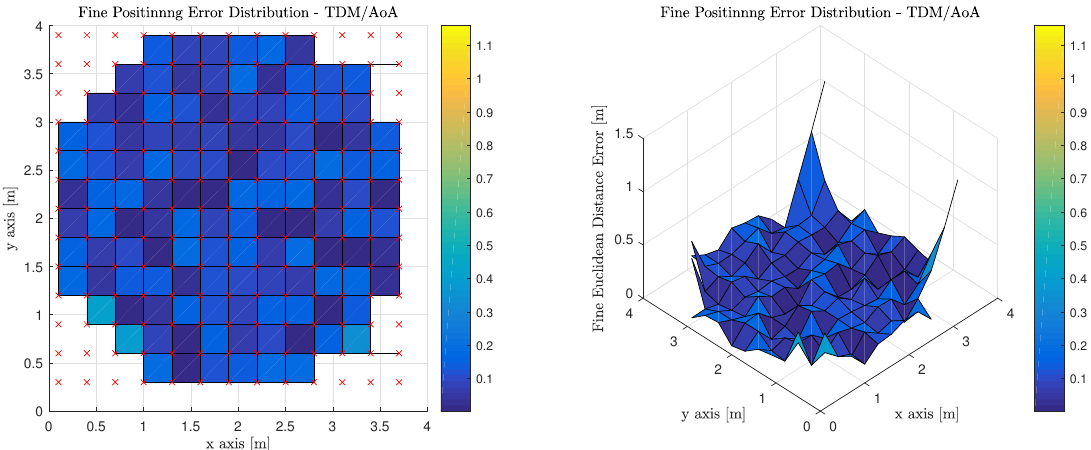
Figure 12. Fine Phase Positioning Performance in Candidate Room using Angle of Arrival Measurement, Geometric Constrained Optimized Triangulation Positioning Algorithm and Time Division